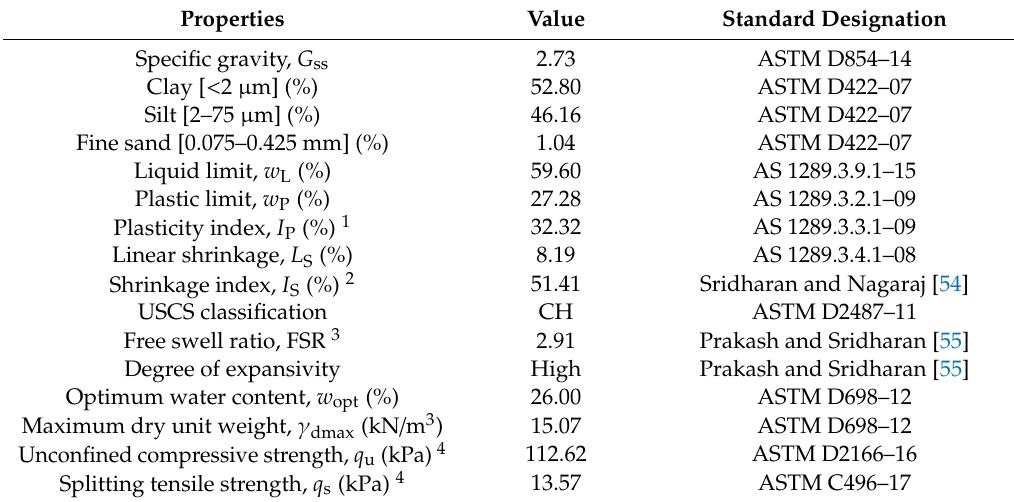
Table 2. Physical and mechanical properties of the expansive clay